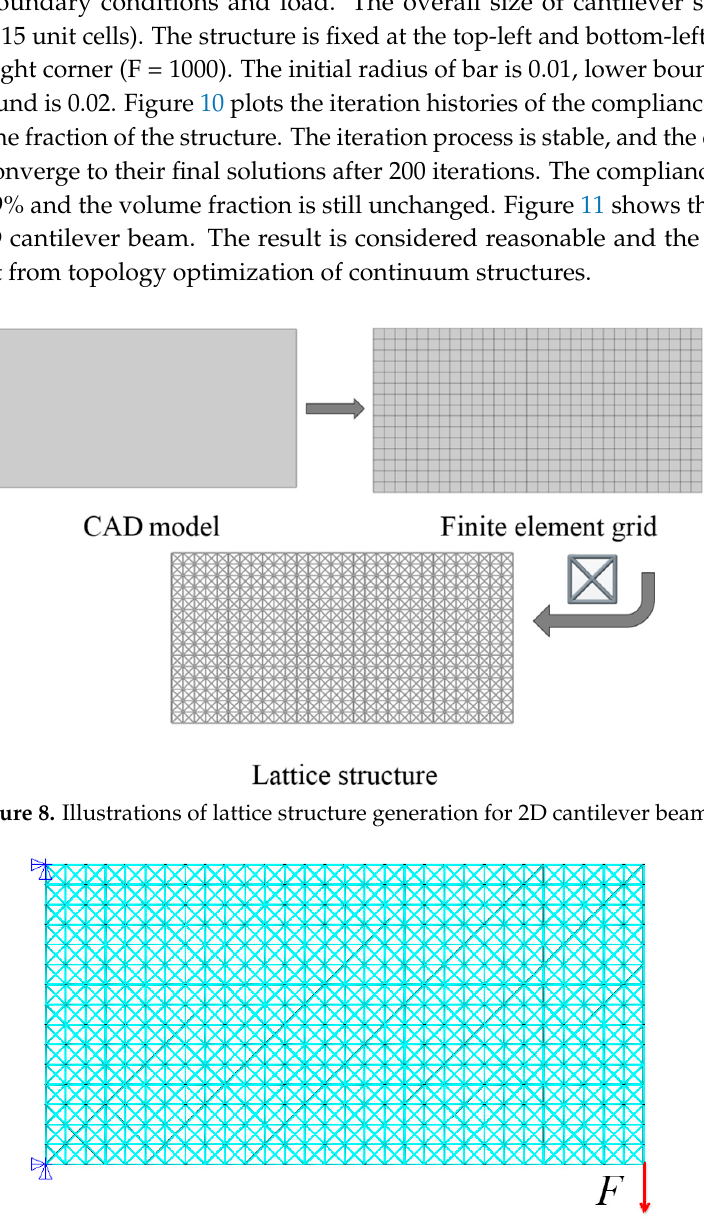
Figure 9. The initial lattice structure, loading and boundary conditions for cantilever beam.